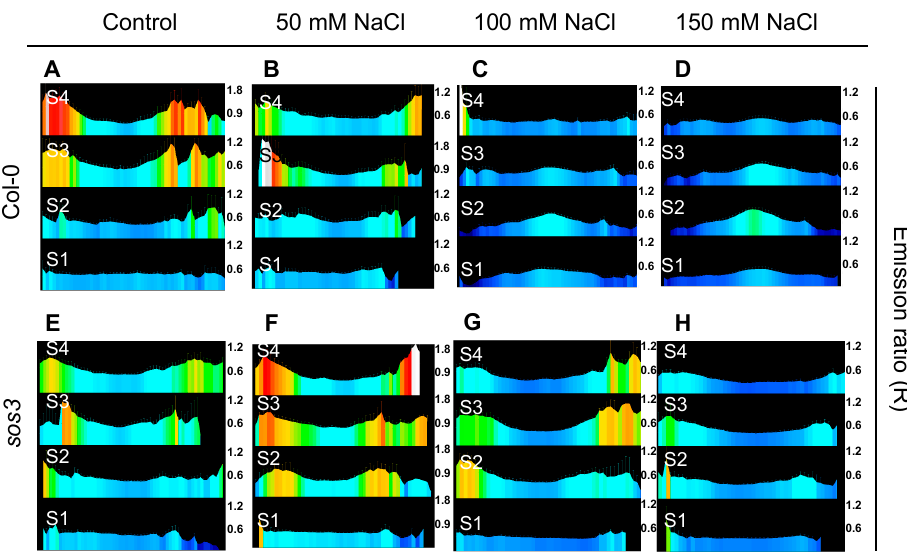
Figure 9. Root pH-maps under salt stress of wild-type Col-0 and sos3 seedlings. Fluorescence emission ratios (R) of pHGFP-LTI6b in 4-day-old seedlings 24 h after being transferred to LAK medium supplemented with the indicated NaCl concentrations. ( A – H ) Panels present the fluorescence emission ratios (R) of cross-sections of the root zones defined in Supplemental Figure S3 of 5–6 seedlings for each segment. The scales of the R values are shown on the right of each panel. The emission ratio (R) data obtained for each seedling in S1 to S4 were aggregated and compared according to the different root tissues as described above, i.e., epidermis plus cortex at both sides of the vasculature (EC1 and EC2) and the vascular bundle (V). The mean emission ratio for each tissue was calculated and plotted (Figure 10). Results show that at 50 mM NaCl, the difference in emission ratio between the vasculature (V) and the surrounding tissues (EC) was statistically more significant in sos3-1 , in contrast to the wild type, because the EC tissues were more alkaline in the mutant. Strikingly, the inverted pattern typical in wild-type seedlings at 100 and 150 mM NaCl, in which the vasculature became more alkaline than the surrounding tissues, was not observed in the sos3-1 mutant (Figure 10). Together, these results point to SOS3 as an important signaling